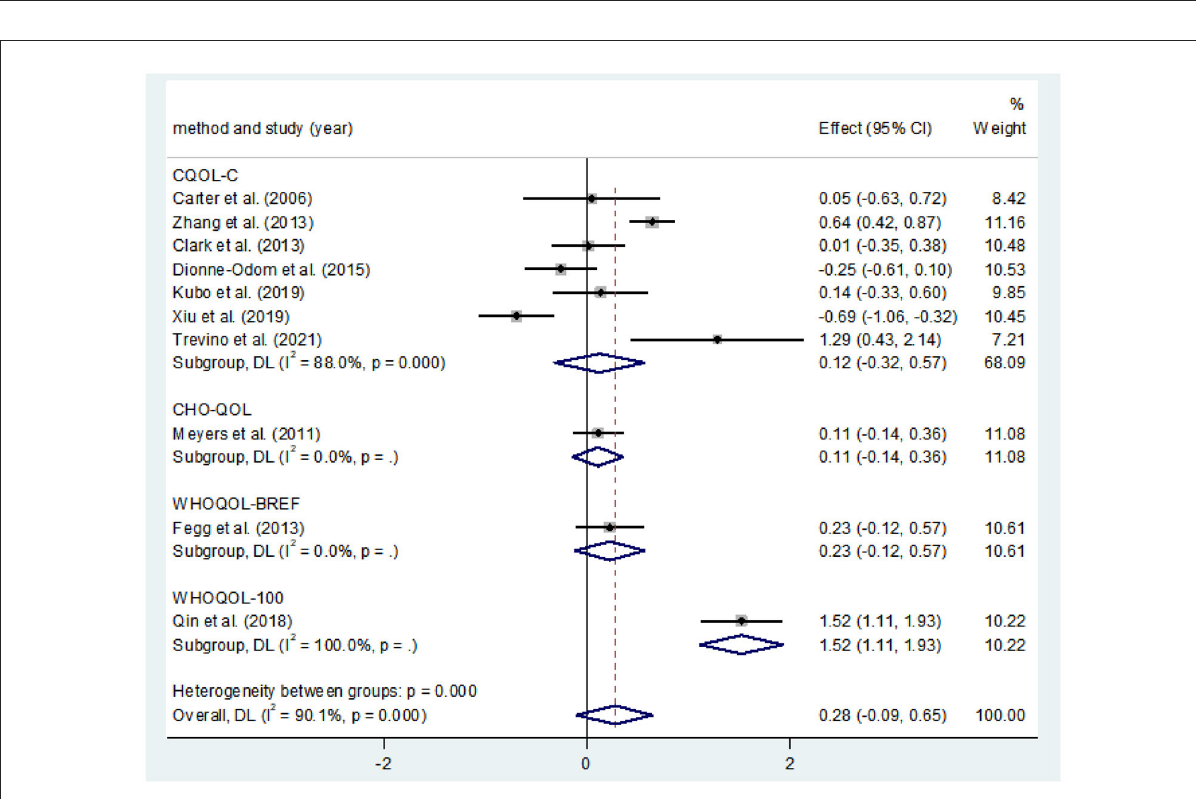
control group of five studies (18, 20, 21, 27, 31) was set as the waiting or delayed intervention group. Among all studies, the overall participant attrition rate was 13.3% and the study